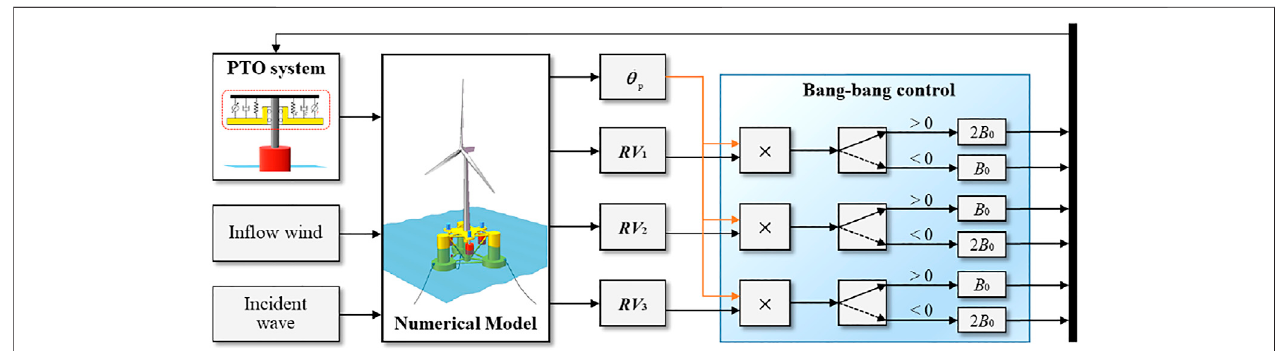
FIGURE 6 | Flow diagram of the bang-bang control for the WEC PTO